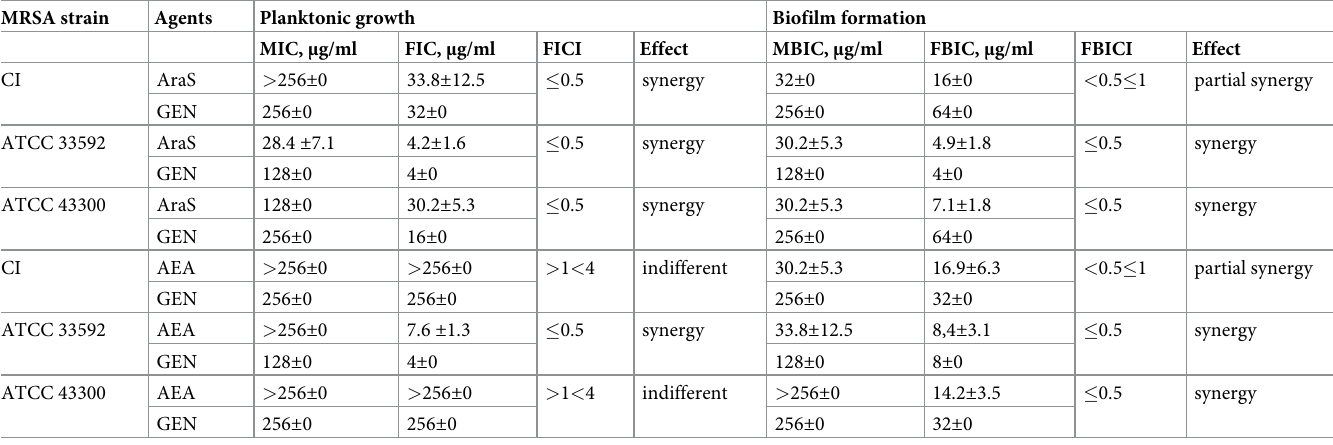
AEA inhibited biofilm formation of two MRSA strains, CI and 33592, at a dose of approxi- mately 32 μ g/ml which was more than 8-fold lower than its MIC ( > 256 μ g/ml) against these strains (Tables 1–4). Biofilm formation of MRSA strain 43300 was not affected by AEA (Tables Table 2. Effects of the combinations of AraS/AEA with GEN against MRSA strains. MRSA